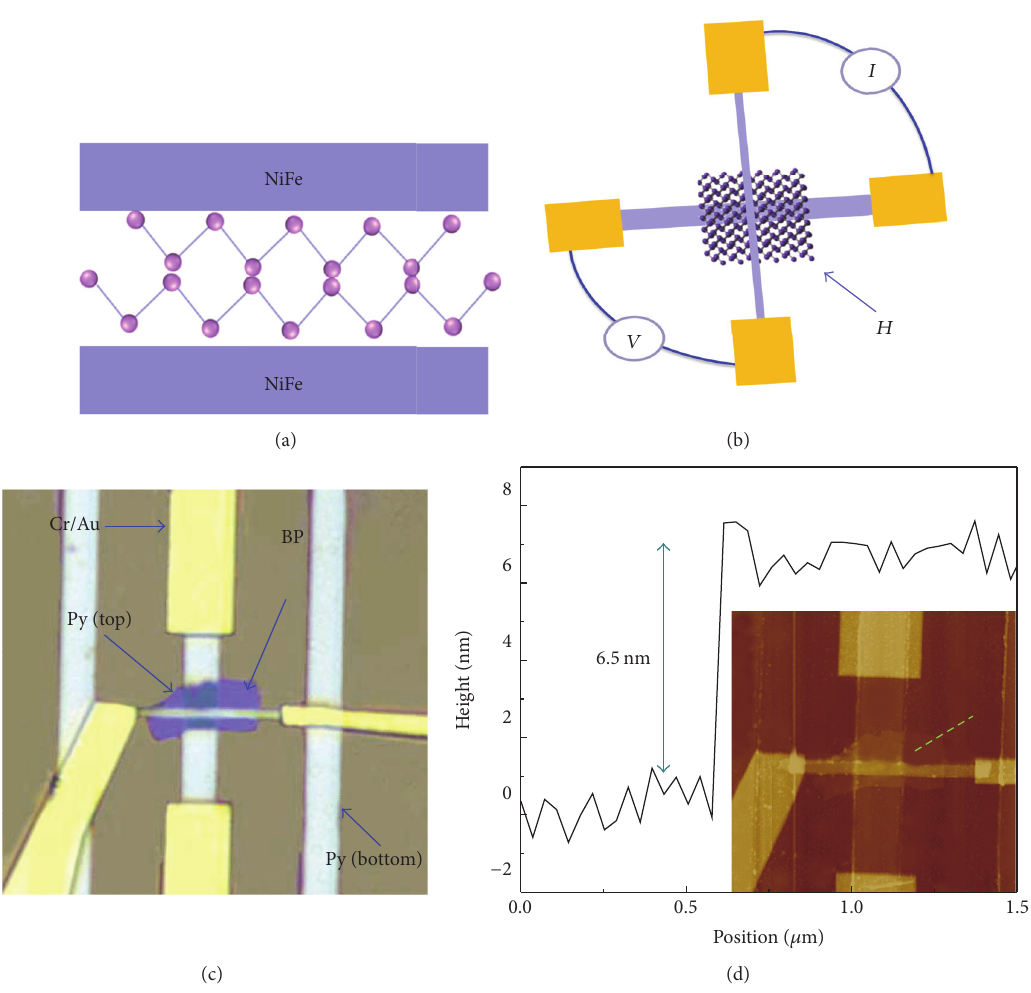
Figure 1: ((a) and (b)) Structure and measurement structure of BP-based vertical spin valve device, consisting of bottom NiFe electrode, 2D-BP spacer, and top NiFe electrode. (c) Optical macrograph of NiFe/BP/NiFe spin valve device. (d) AFM graph of